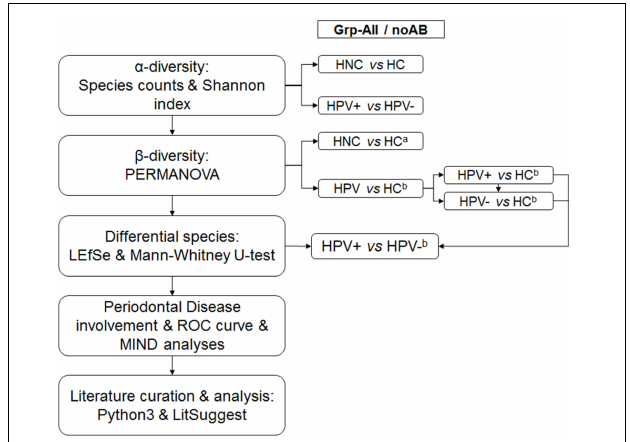
FIGURE 1 | Overall analytical strategy. α -Diversity was calculated for Grp-All HNC vs. HC ( N = 30; N = 20) and HPV+ vs. HPV– ( N = 16; N = 7) and for Grp-noAB HNC vs. HC ( N = 19; N = 20) and HPV+ vs. HPV– ( N = 12; N = 3). Sample sites consisted of different combinations of buccal (B), plaque